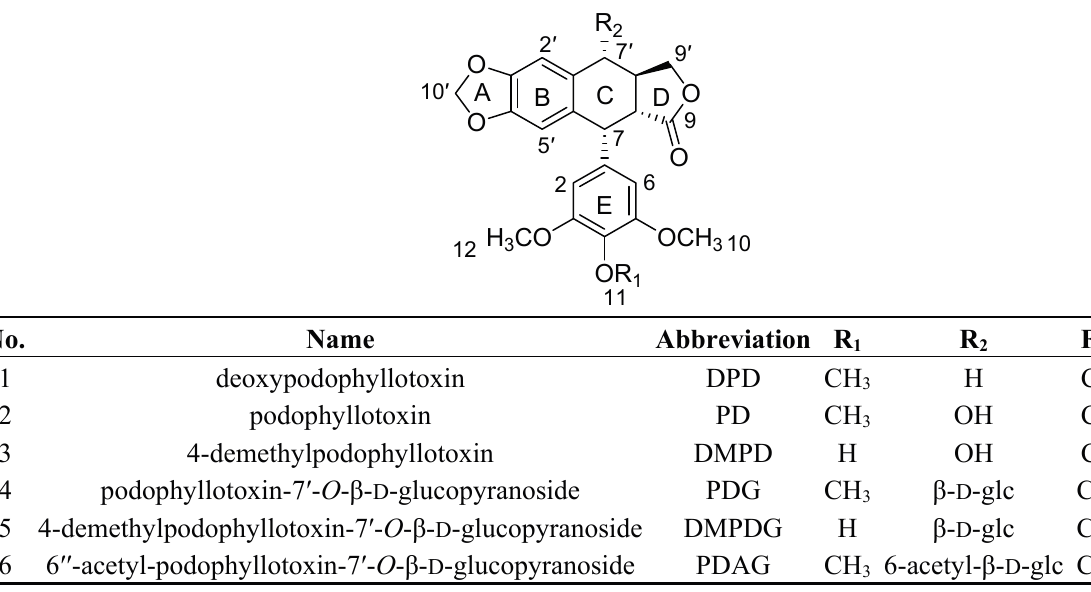
Table 1. Chemical structures of aryltetralin lactone lignans